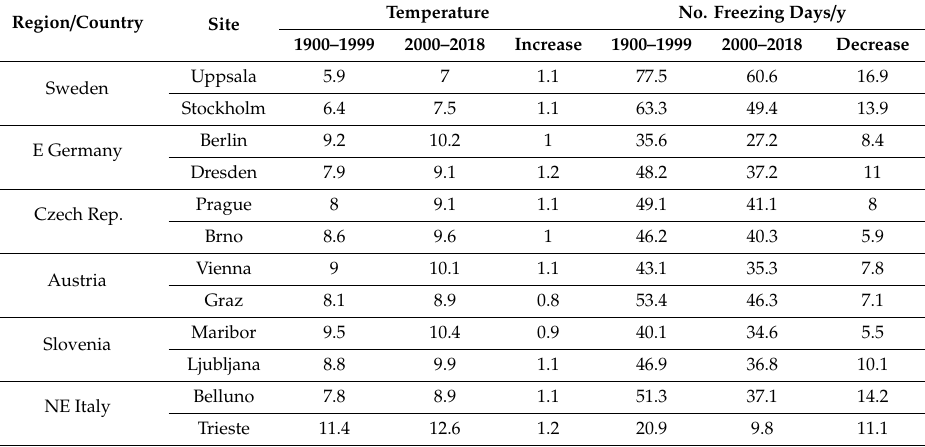
Table 2. The latitudinal gradient in terms of average temperature and the number of freezing days at selected sites in the periods indicated [25]. Note irregularities related to altitude and